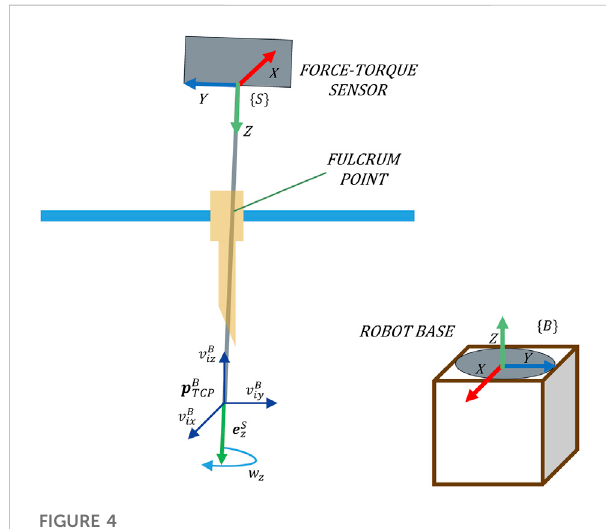
FIGURE 4 Four DoFs released at the TCP by the proposed force-based pivoting motion